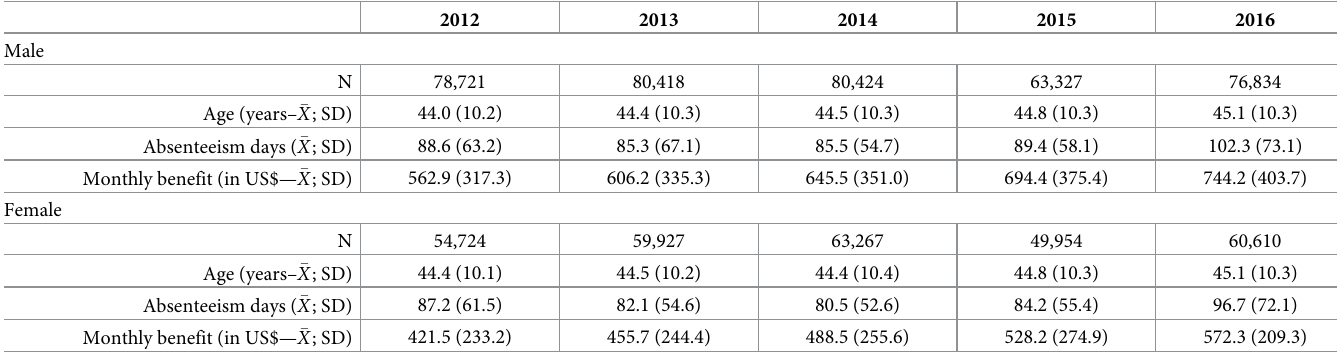
Table 3. Data on sick leave due to low back pain in the 5-year period investigated, for male and female workers.